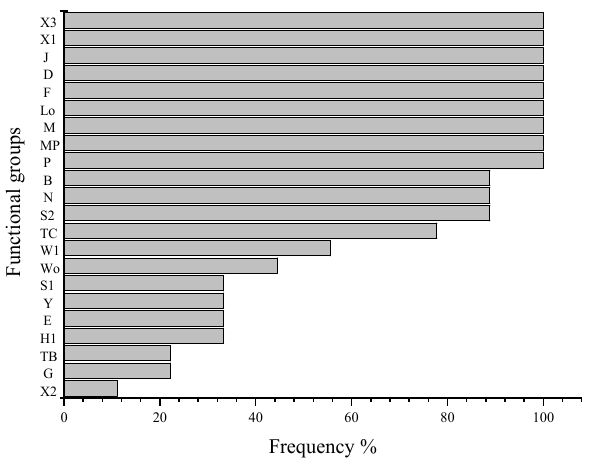
Figure 2. Frequency of phytoplankton functional groups in Nanhai Lake.